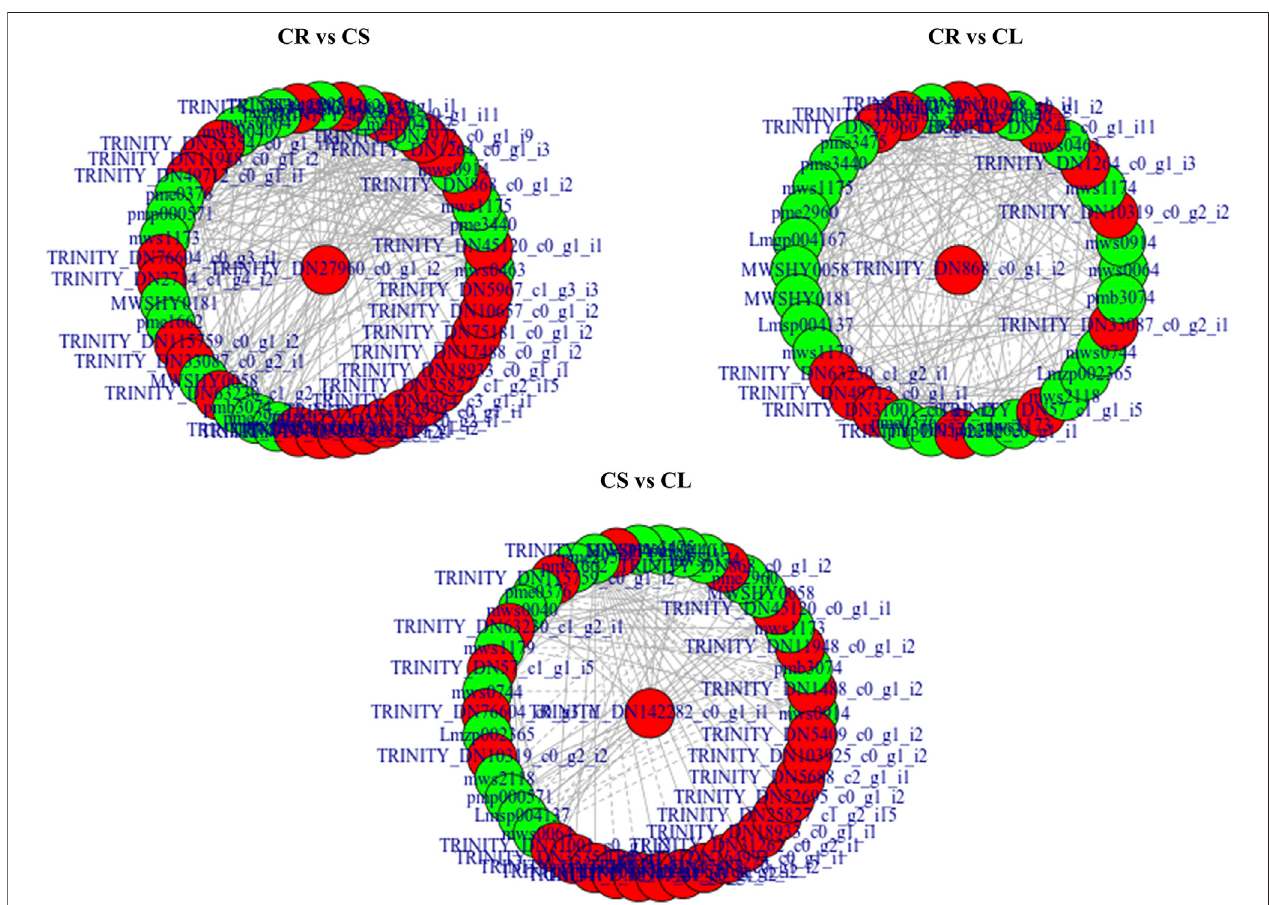
FIGURE8| Networkshowingcorrelation( > 0.8)betweentheDEGsandDAMsenrichedin fl avonoidbiosynthesispathway.Metabolitesaremarkedingreen,genes are marked in red, solid lines represent positive correlation, and dotted lines represent the negative correlation.